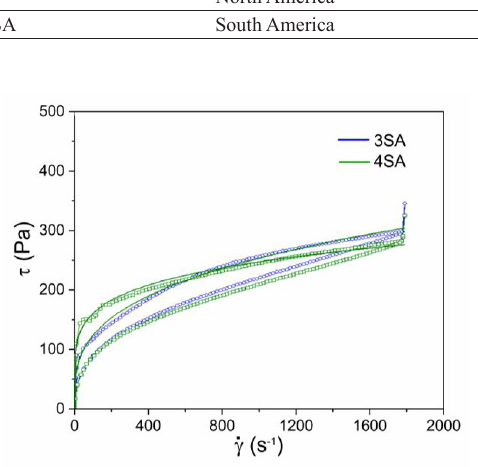
Figure 1. Rheological curves for shear stress (τ) versus shear rate